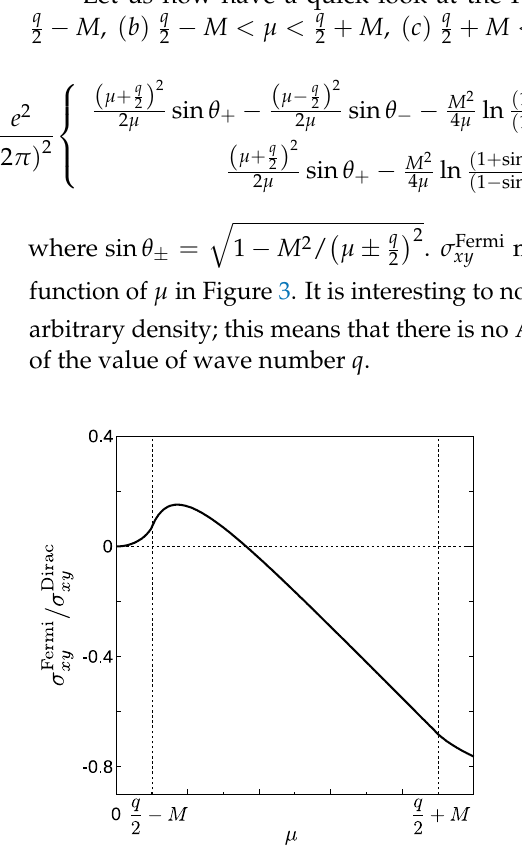
Figure 3. Density dependence of (cid:3435)𝜎 (cid:3051)(cid:3052)(cid:2890)(cid:2915)(cid:2928)(cid:2923)(cid:2919) (cid:3439)